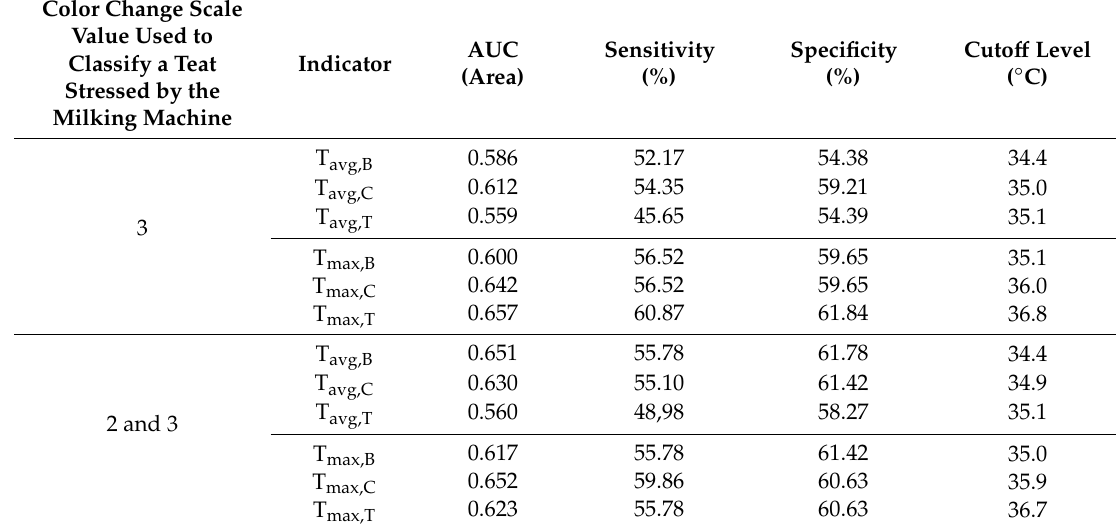
Table 2. Final performances of the statistical tests based on the evaluation of the indicators T avg,B , sensitivity, specificity, and the corresponding cuto ff level are reported for each indicator and criterion of reclassification of the teat status. The values reported in the table were calculated through a customized function developed for the “R” statistical software